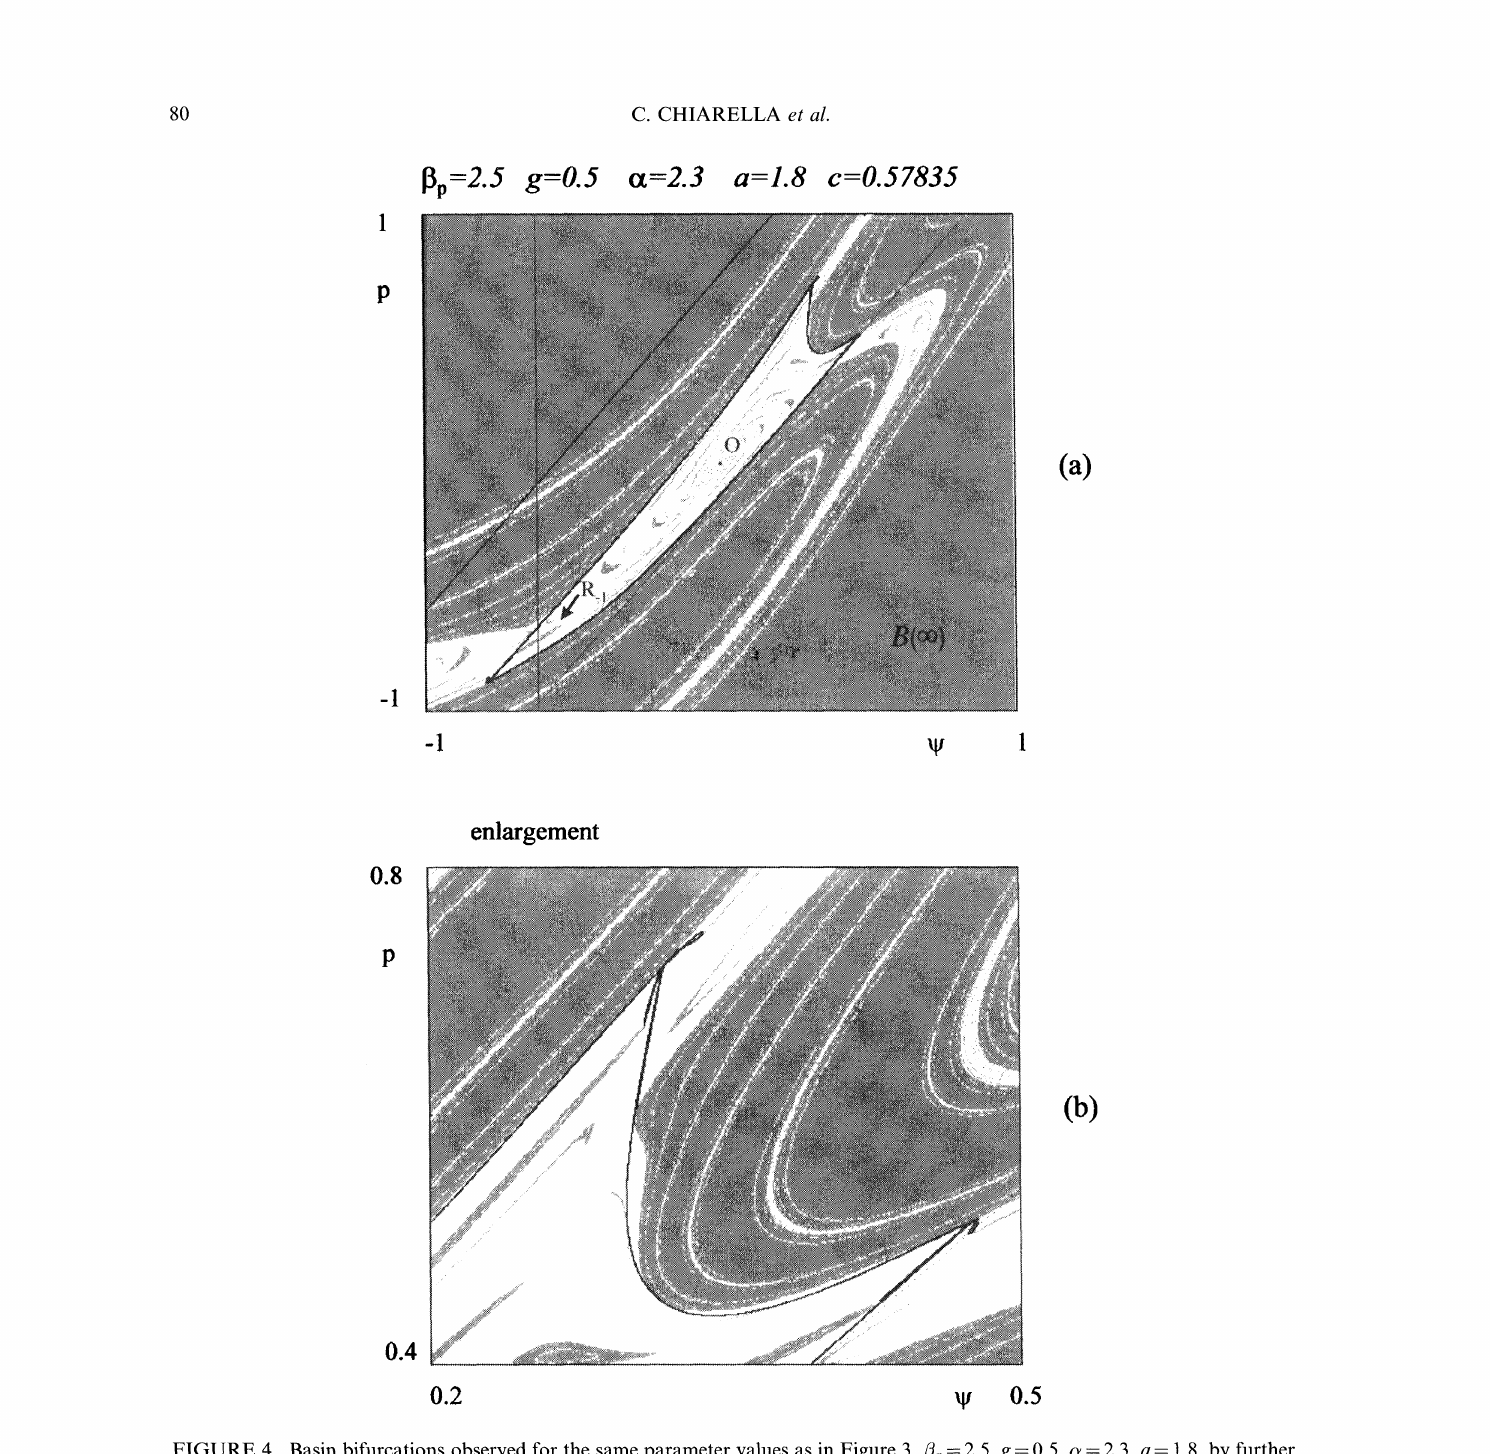
FIGURE 4 Basin bifurcations observed for the same parameter values as in Figure 3, tip 2.5, g 0.5, c 2.3, a 1.8, by further increasing c (c 0.57835). Holes are now also inside the area bounded by the attracting set (a). Figure (b) is an enlargement of (a), and shows that the attractor is no longer a closed invariant curve homeomorphic to a